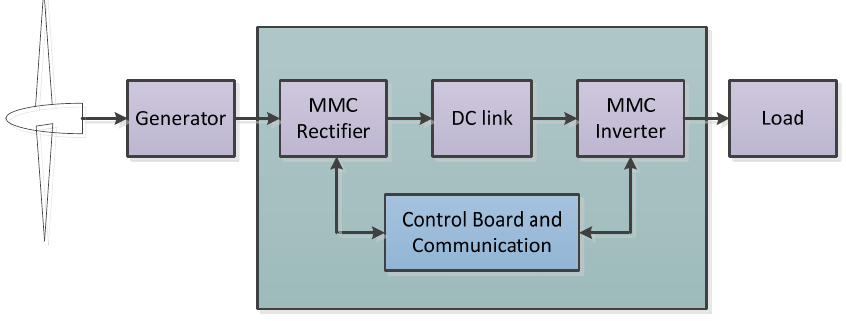
Figure 1. Wind power generation HVDC transmission